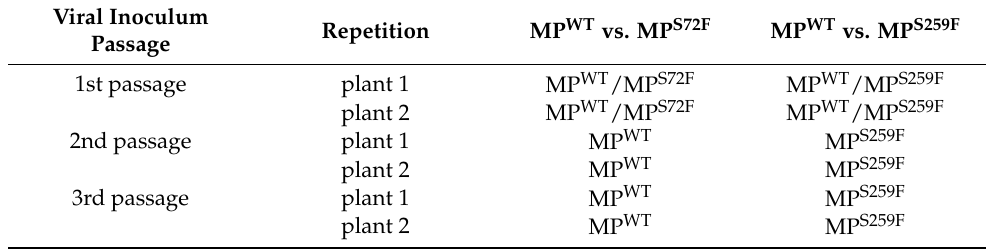
Table 1. Viral fitness assay between the AMV RNA 3 constructs carrying the CiLV-C2 MP wild type (MP WT ) and its MP S72F or MP S259F